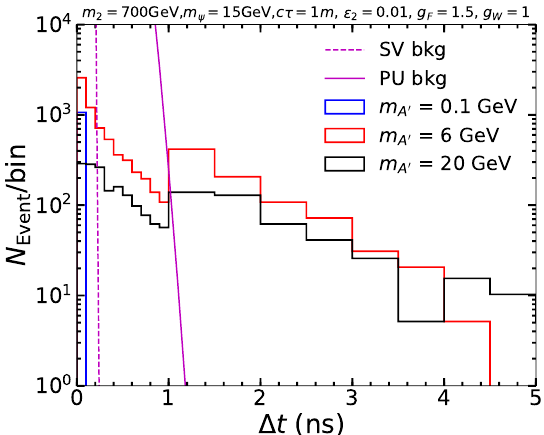
Figure 5 . The distribution of the time delay (cid:1) t , with the integrated luminosity L = 3ab (cid:0) 1 . p T > 3 GeV is required for the leading lepton. The bin width is 0.5 (0.1) ns for (cid:1) t > 1 ns ((cid:1) t < 1 ns). We choose m 2 = 700 GeV, m = 15 GeV, c(cid:28) = 1 m, (cid:15) 2 = 0 : 01, g F = 1 : 5 and g W = 1 : 0. The solid blue, red and black lines indicate the dark photon mass of 0.1 GeV, 6 GeV and 20 GeV. The solid and dashed magenta curves represent the PU and SV backgrounds respectively.